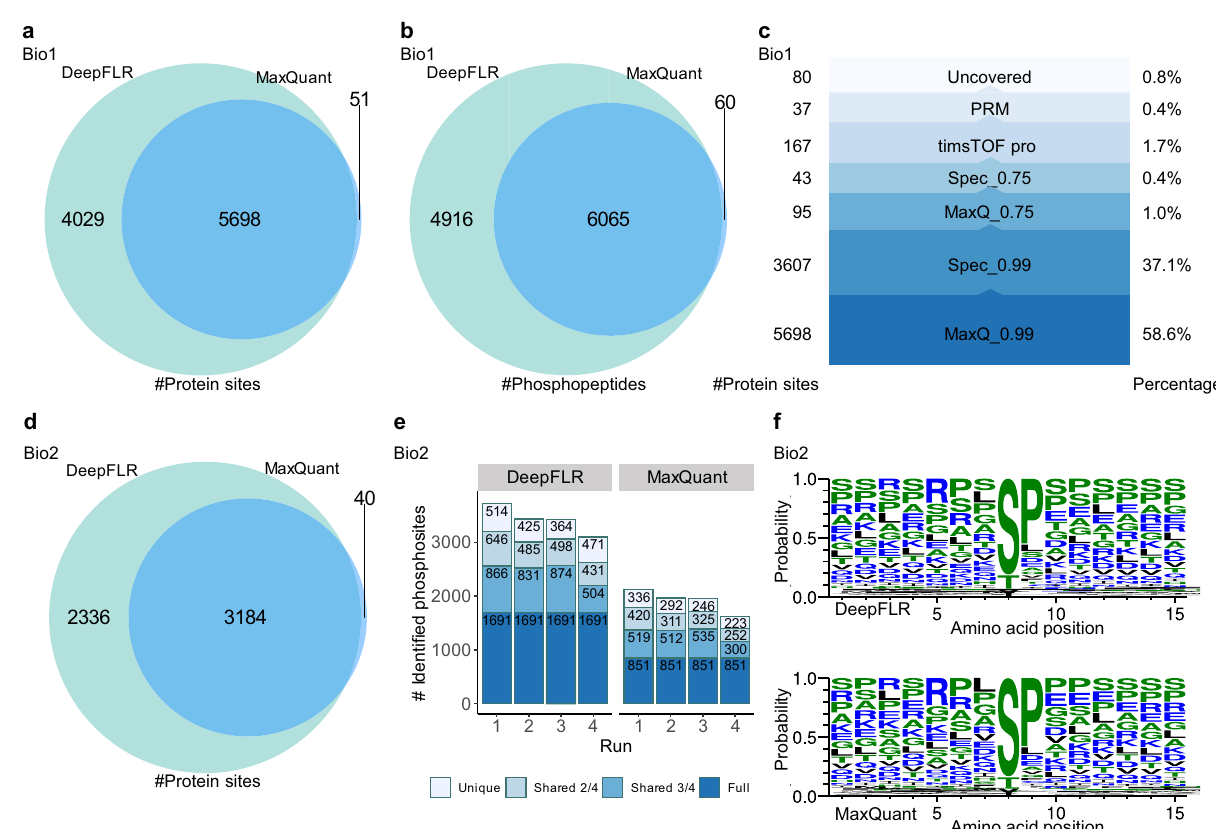
Fig.3|AnalysisofbiologicalsamplesBio_1andBio_2byDeepFLR. Venndiagram of the number of a protein phosphosites and b phosphopeptides identi fi ed by DeepFLR and MaxQuant for Bio_1. c Stepwise coverage of the DeepFLR localized phosphosites. The height of the bar chart is proportional to the log value of the number of additionally localized protein phosphosites. MaxQ_0.99 (0.75): Max- Quantwith0.99(0.75)localizationprobability;Spec_0.99(0.75):SpectroMinewith 0.99 (0.75) localization probability. PRM: parallel reaction monitoring. d Venn diagram of the number of phosphosites identi fi ed by DeepFLR and MaxQuant for